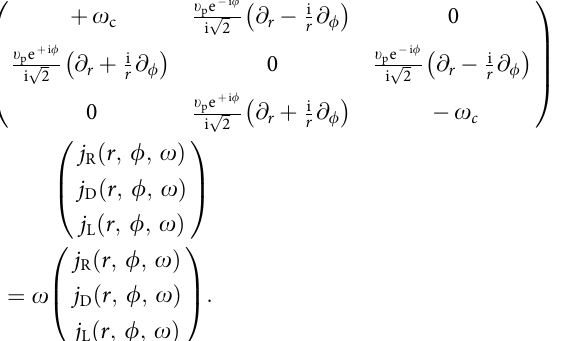
Figure 5 | Topological zero mode. ( a ) Illustration of a hollow disk geometry and zero-mode profile attached to the inner circular edge. ( b ) Spectrum of bulk states and edge states versus the discrete angular momentum n ¼ 0 ; (cid:8) 1 ; (cid:8) 2 ; ...